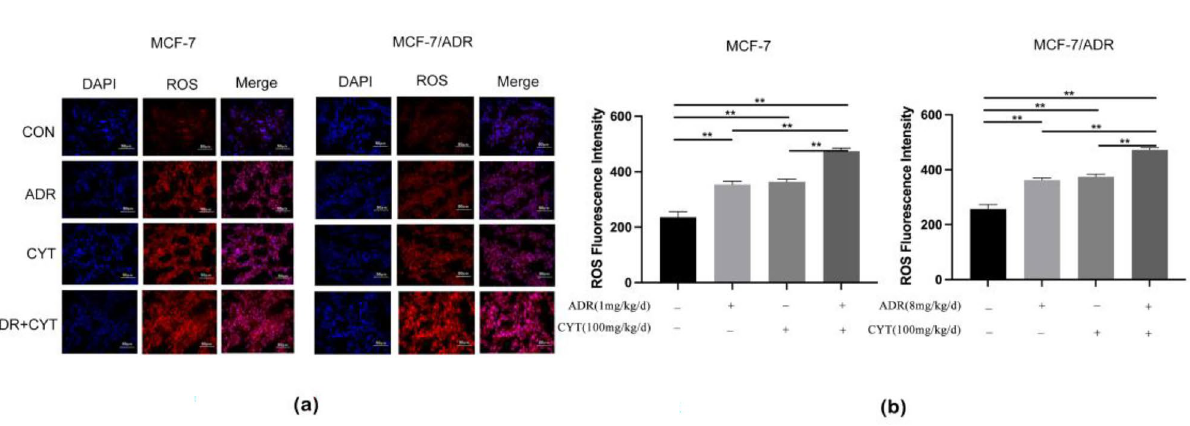
Figure 6. CYT combined with ADR exhibited significantly inhibitory effects in tumor-bearing nude mice by ROS generation. ( a ) The expression of ROS in tissues was detected by immunofluorescence. ( b ) The fluorescence intensity of ROS was detected by image